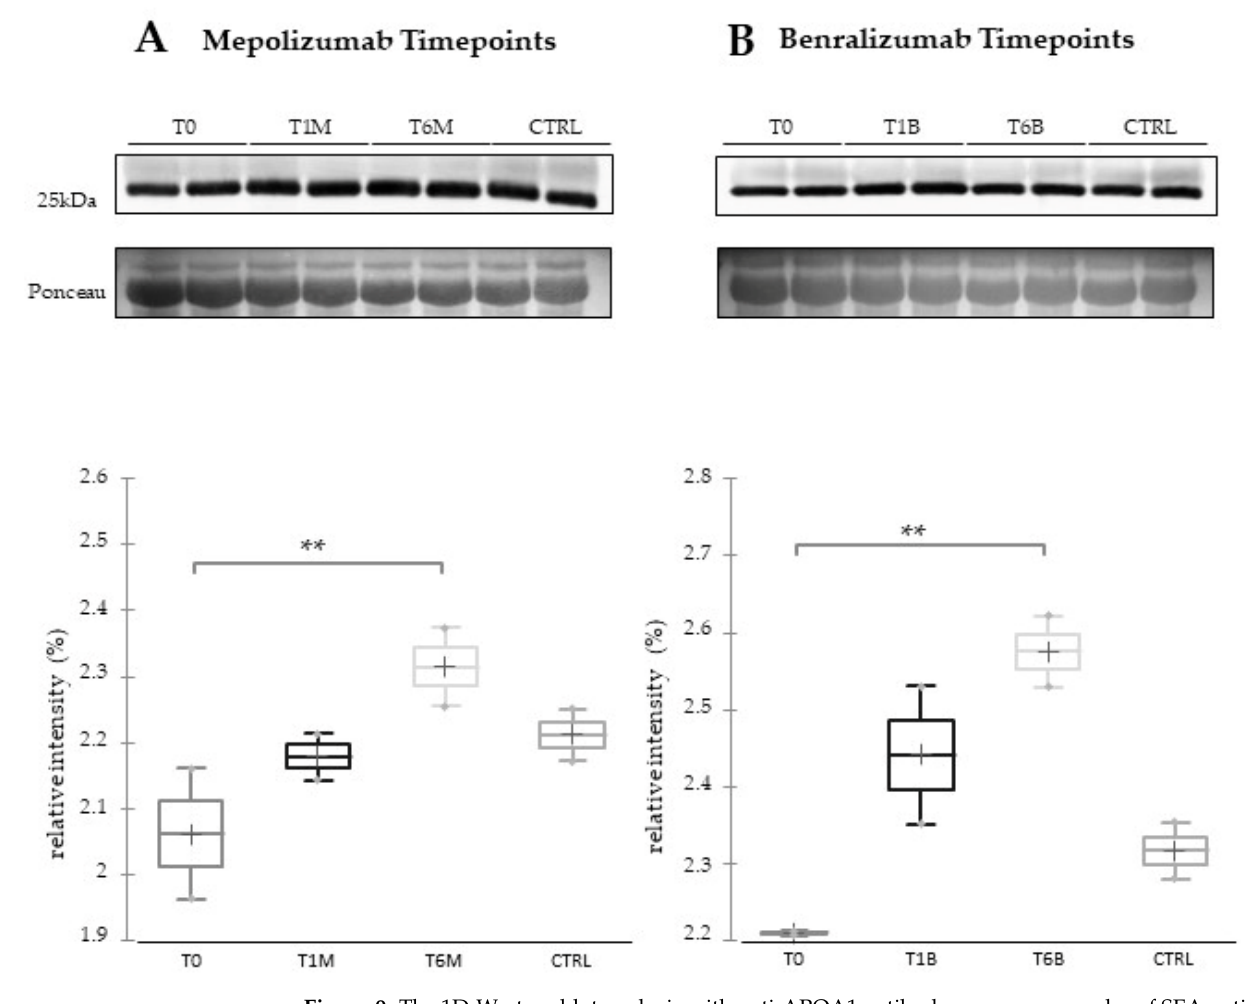
Figure 9. The 1D-Western blot analysis with anti-APOA1 antibody on serum samples of SEA patients at T0, T1M, and T6M ( A ) or T0, T1B, and T6B ( B ) and CTRLs. Kruskal–Wallis statistical analysis validates the upregulation of APOA1 after 6 months of monoclonal therapies (** = p ≤ 0.025) .